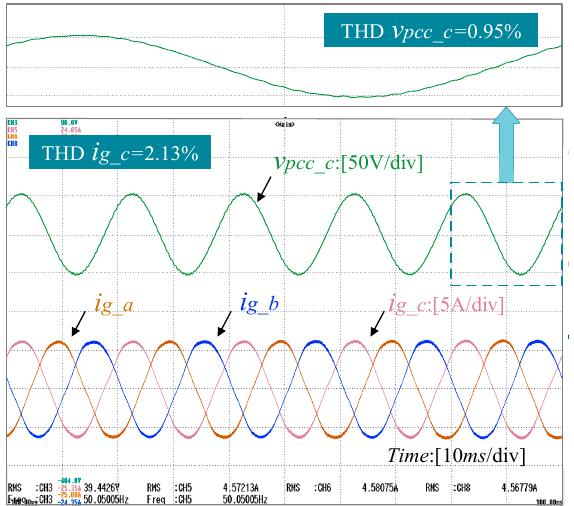
Figure 20. Steady ‐ state responses when Lg is 3 mH.